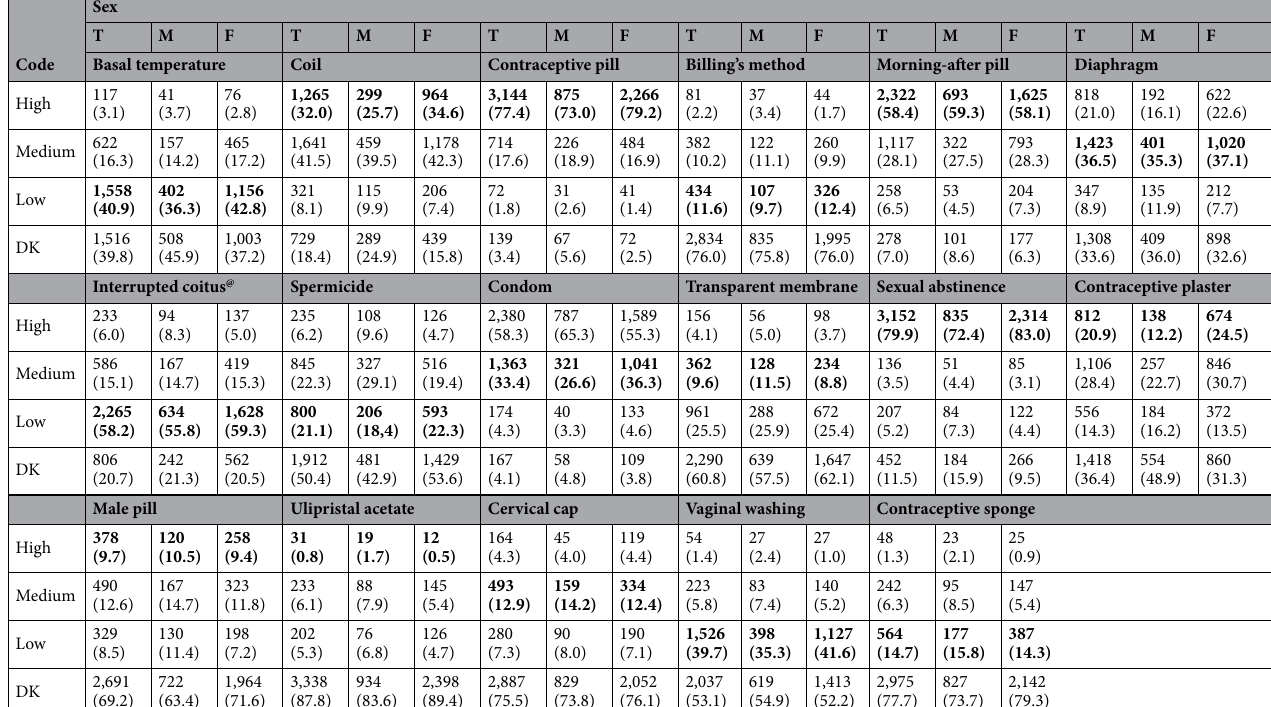
Table 3. Distribution of 17 contraceptive methods by code of efficacy to prevent unintended pregnancies (High, Medium, Low, DK = Don’t know) and sex (T = Total; M = Males, F = Females). Number of answers provided (correct answers bold marked) with column percentages (%). @